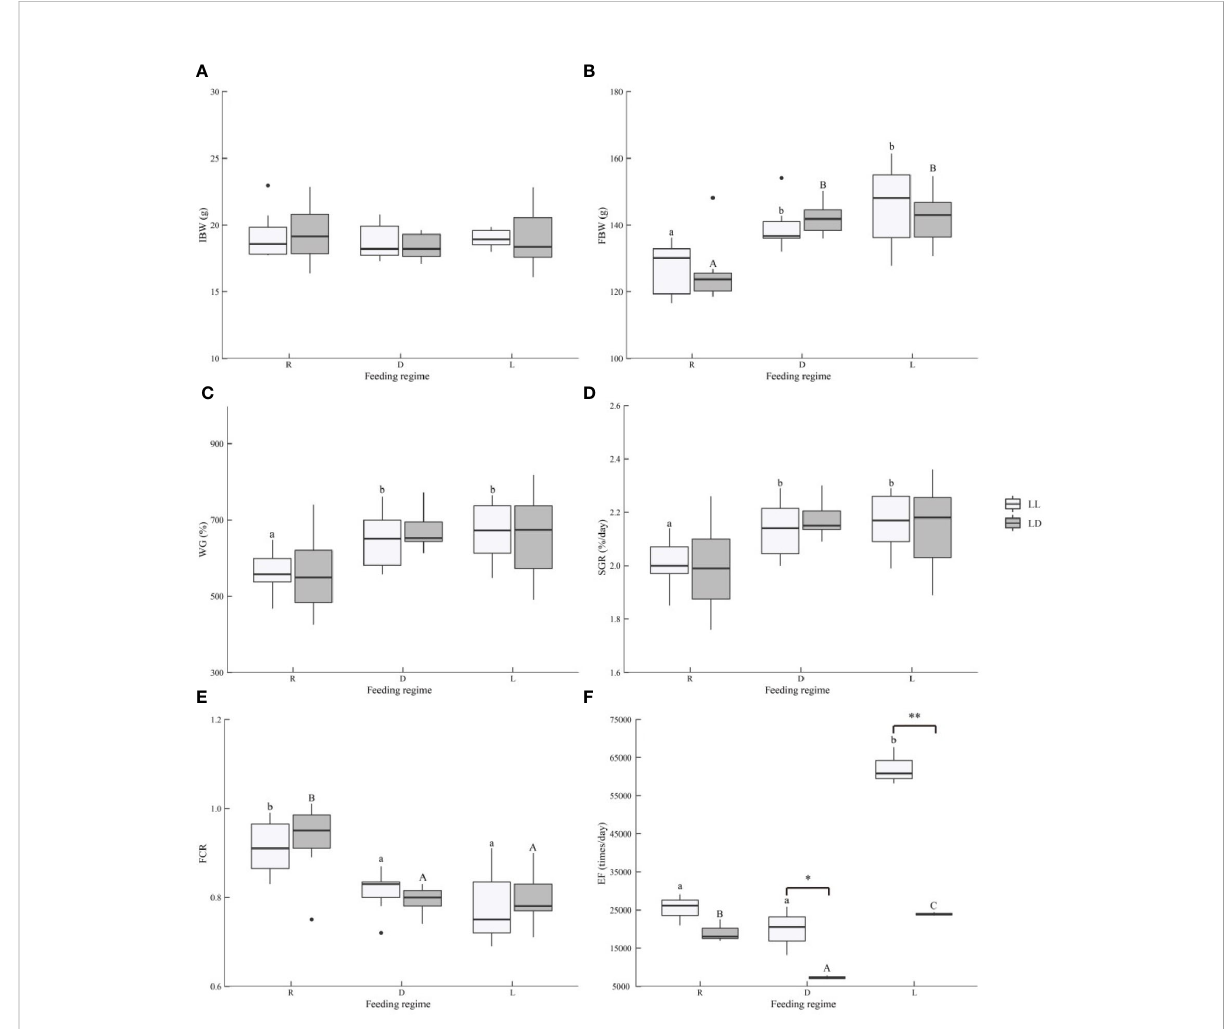
FIGURE 1 Growth performance, feed utilization, and locomotion of juvenile Oncorhynchus mykiss under different experimental treatment. (A) . IBW, Initial body weight, (B) . FBW, Final body weight, (C) . WG, Weight gain (%) = 100 × ( fi nal weight − initial weight)/initial weight, (D) . SGR, Speci fi c growth rate (%/day) = 100 × (ln fi nal weight − ln initial weight)/94 days, (E) . FCR, Feed conversion ratio = dry feed consumed/wet weight gain, (F) .